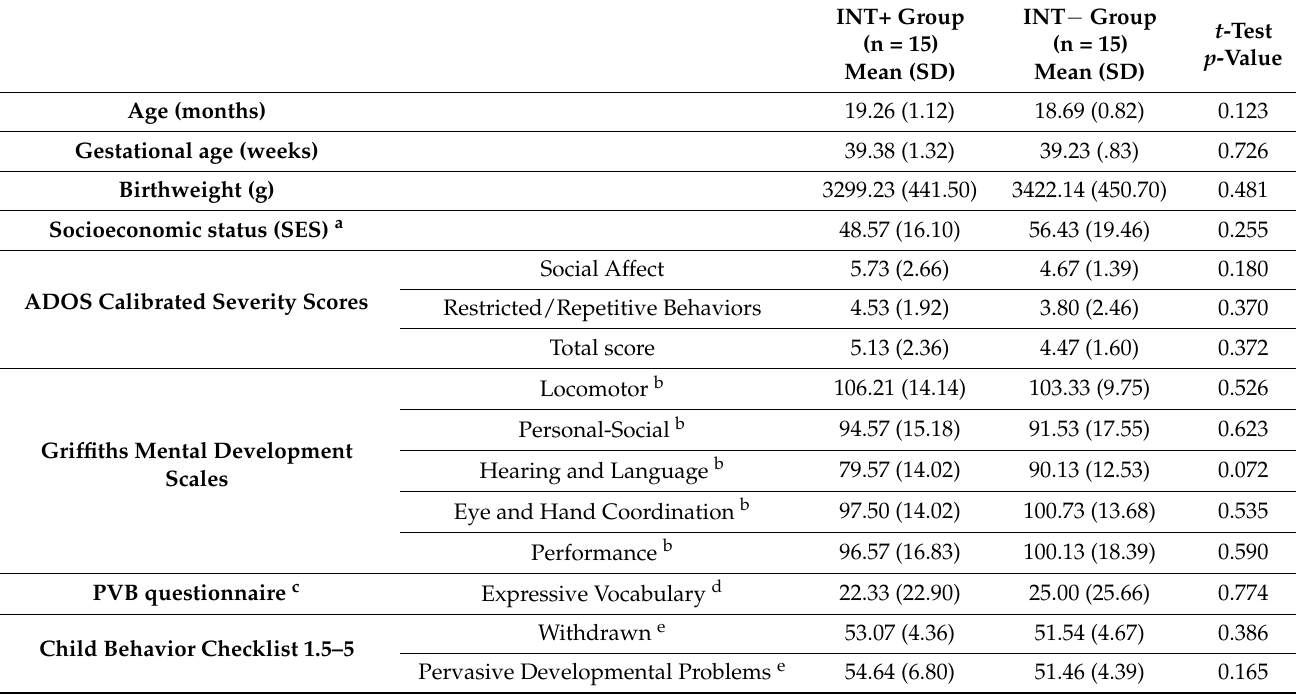
Table 1. Baseline characteristics for INT+ and INT −